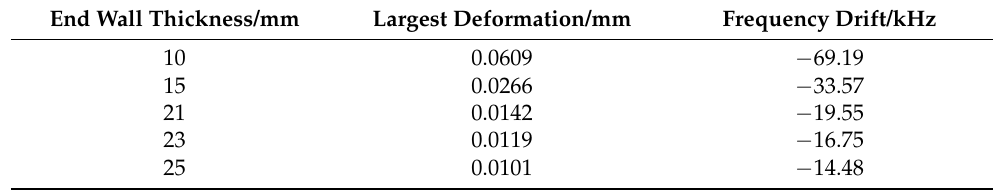
Table 4. Simulation results of the largest deformation and frequency drift with different end wall thickness.